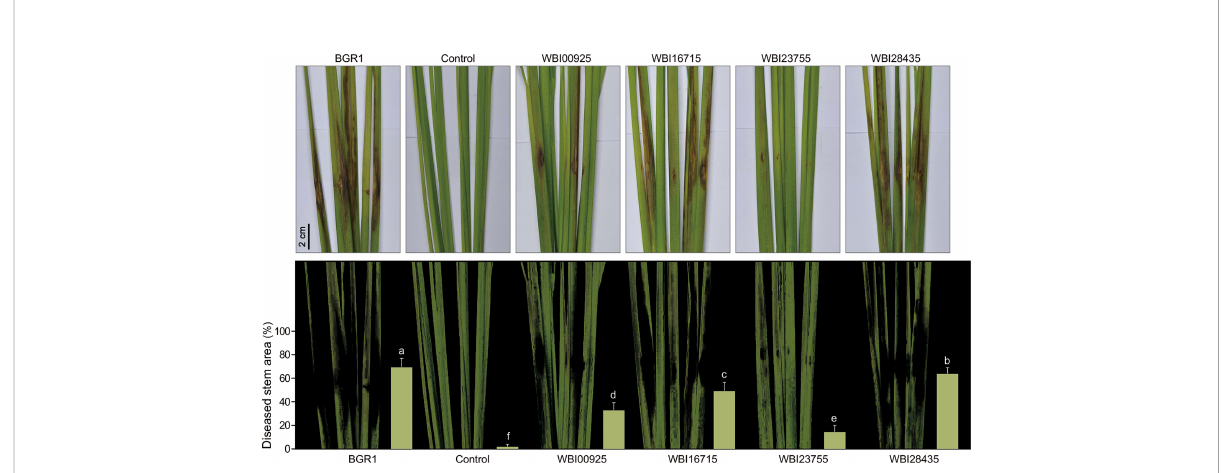
FIGURE 4 A single colony inoculation assay of (B) glumae mutants in rice stems At the vegetative stage, rice stems (cv. Dongjin) were inoculated using a syringe needle (~1 mm puncture) with bacterial colonies of the wild-type ( B ) glumae (BGR1) and the mutant strains de fi cient in each of the shared key functional genes (WBI00925, WBI16715, WBI23755, and WBI28435). Uninoculated plants served as negative controls. Infection courts of rice stems were photographed seven days after bacterial inoculation (upper panel). Lesion areas were captured and measured using Adobe Photoshop CS6 with the color range module (lower panel). Disease severity triggered by each strain was assessed from the percentage of diseased stem area as a bar chart. Error bars represent standard errors ( n = 9). Different lowercase letters on the error bar indicate signi fi cant difference between treatments according to the least signi fi cant difference test at P ≤